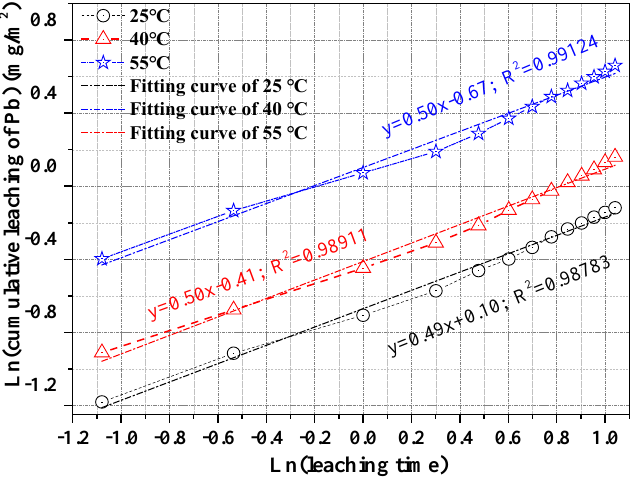
Figure 4. Fitting curves of leaching results under different temperatures.